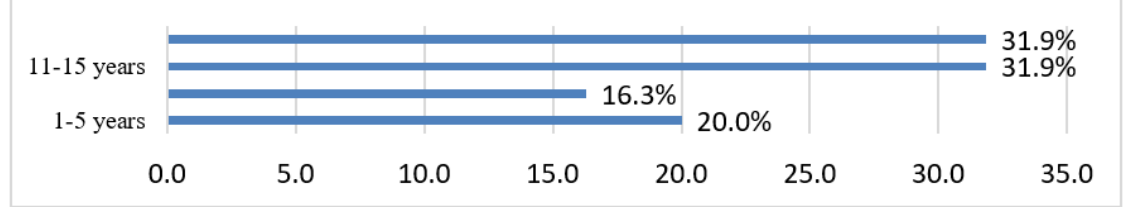
Figure 3. Respondents’ years of experience.